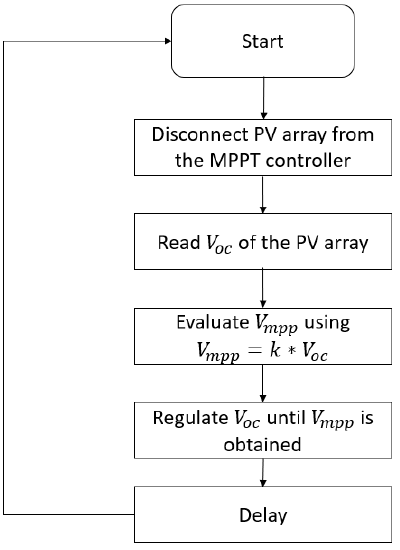
Figure 4. Flowchart of the CV method [22] .